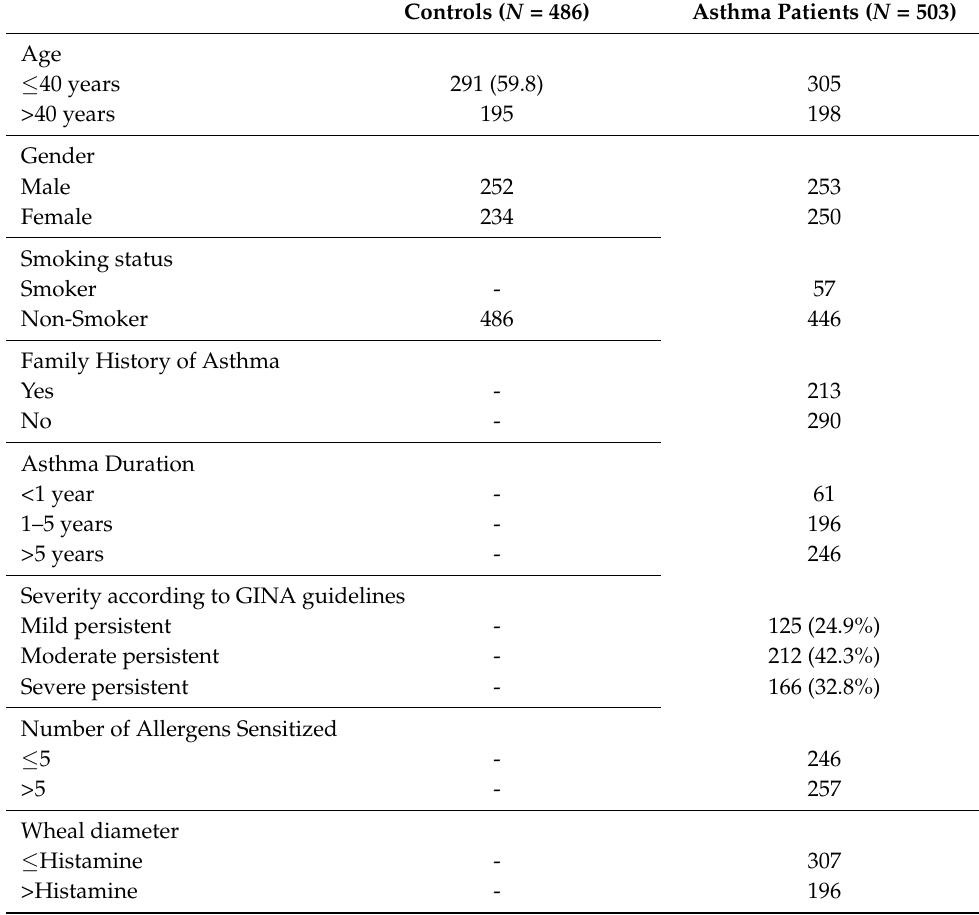
Table 1. Demographic profile of the study patients.